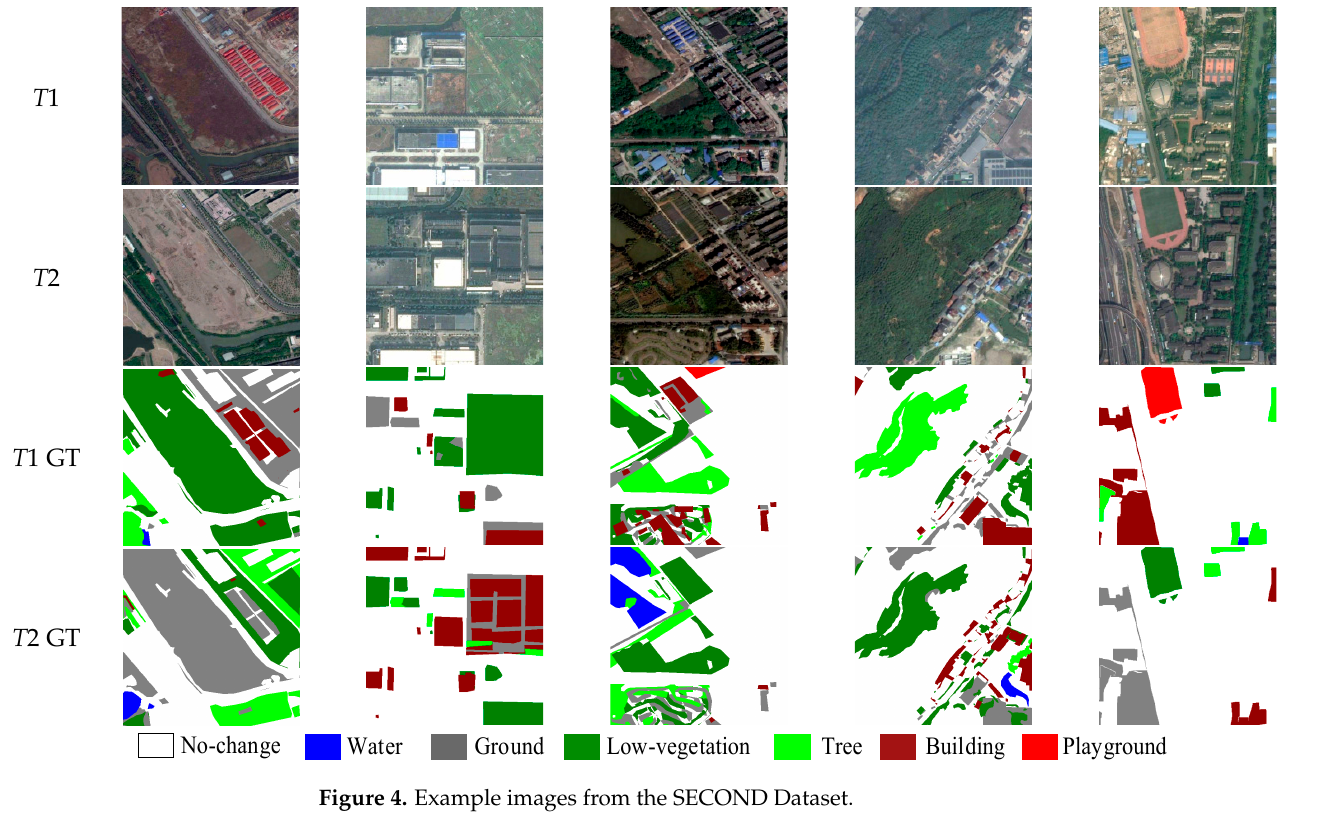
Figure 4. Example images from the SECOND Dataset.